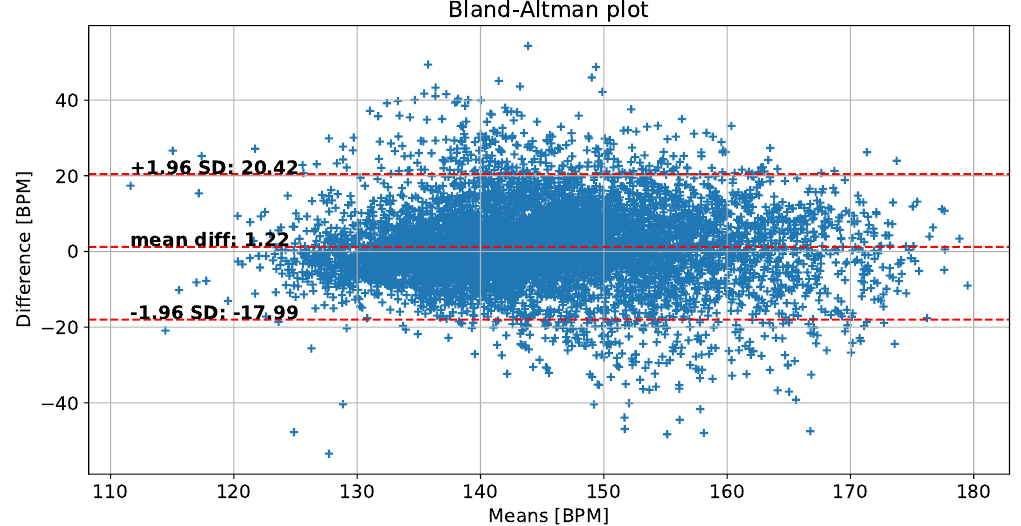
Figure 11. The Bland–Altman plot of results of Physnet+RateEstNet and reference